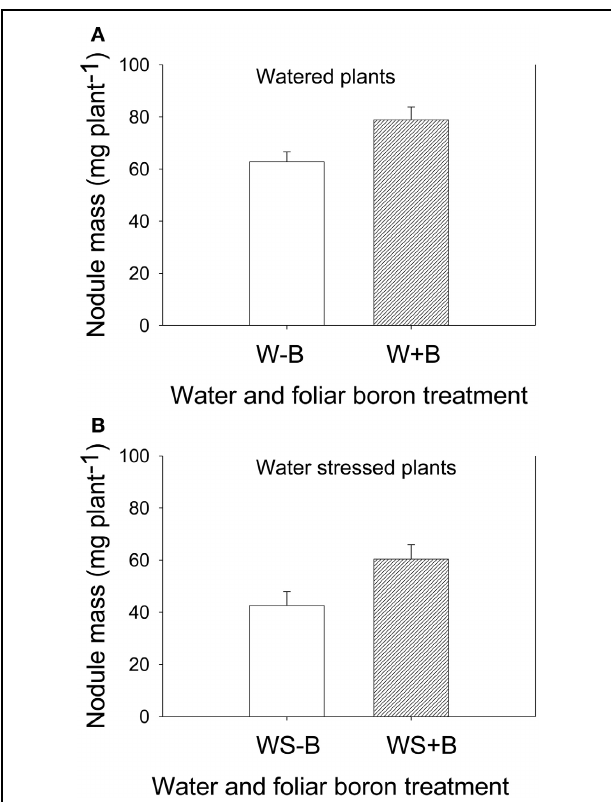
FIGURE 1 | Effect of foliar boron application (1.1kg ha − 1 ) on nodule mass (g plant − 1 ) in watered plants (A) and water stressed